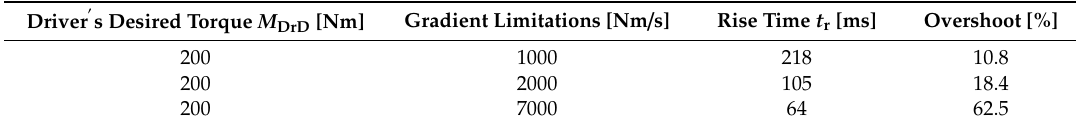
Table 1. Parameters and compared values of the